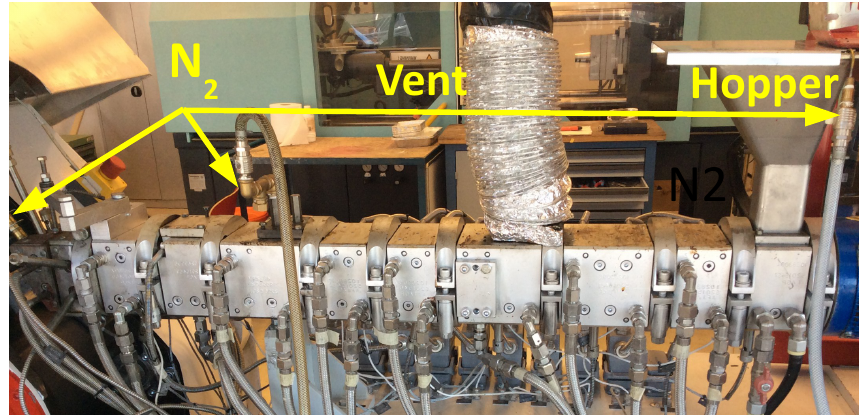
Figure 4. Extruder with the supply hopper, ventilation point and nitrogen supplies.